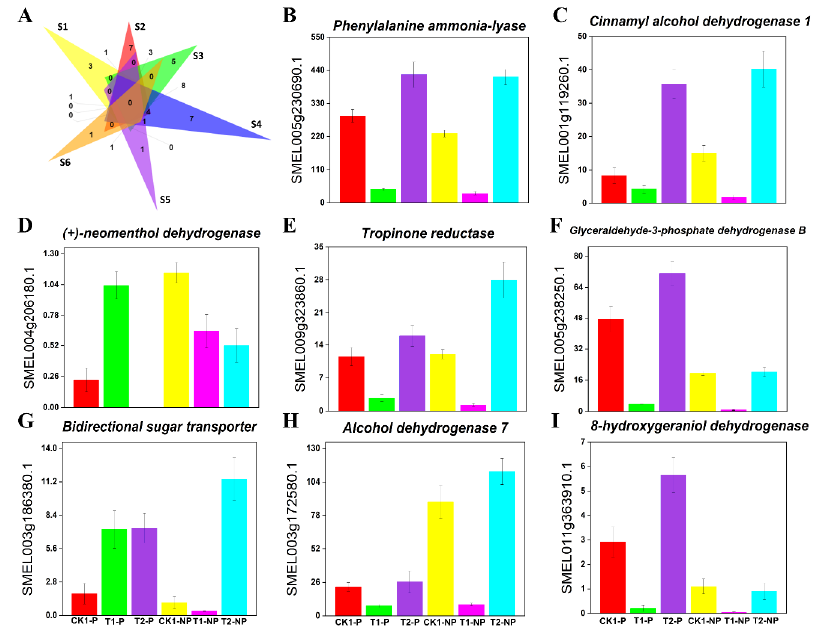
Figure 7. Effects of shading and light on gene expression and signal transduction related to eggplant peel flavor and aromatic compounds. ( A ) Venn diagram showing differentially expressed genes related to eggplant peel flavor and aroma in the six comparison groups (S1: CK1-P vs. T1-P; S2: T1-P vs. T2-P; S3: CK1-NP vs. T1-NP; S4: T1-NP vs. T2-NP; S5: T1-P vs. T1-NP; S6: T2-P vs. T2-NP); ( B ) Phenylalanine ammonia-lyase ( PAL ); ( C ) Cinnamyl alcohol dehydrogenase 1 ( CAD1 ); ( D ) (+)- neomenthol dehydrogenase ((+)- ND ); ( E ) Tropinone reductase (TR) ; ( F ) Glyceraldehyde-3-phosphate dehydrogenase B ( GAPB ); ( G ) Bidirectional sugar transporter ( SWEET ); ( H ) Alcohol dehydrogenase 7 ( AD7 ); and ( I ) 8-Hydroxygeraniol dehydrogenase ( 8HGO ). (( B – I ): The X-axis represents different eggplant groups, and the Y-axis represents FPKM